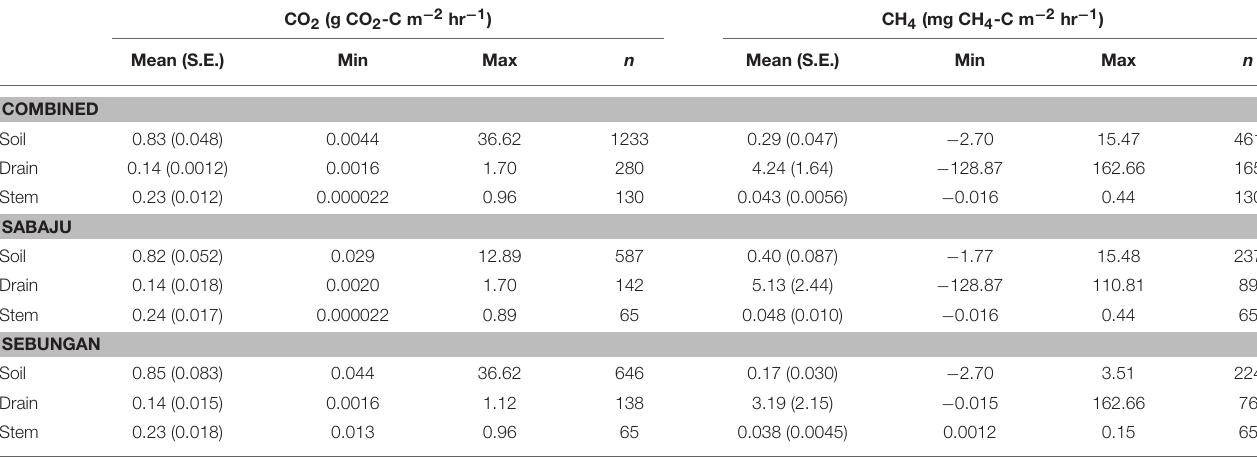
TABLE 2 | Summaries of the mean, minimum, maximum and number of CO 2 and CH 4 fluxes measured in this study.